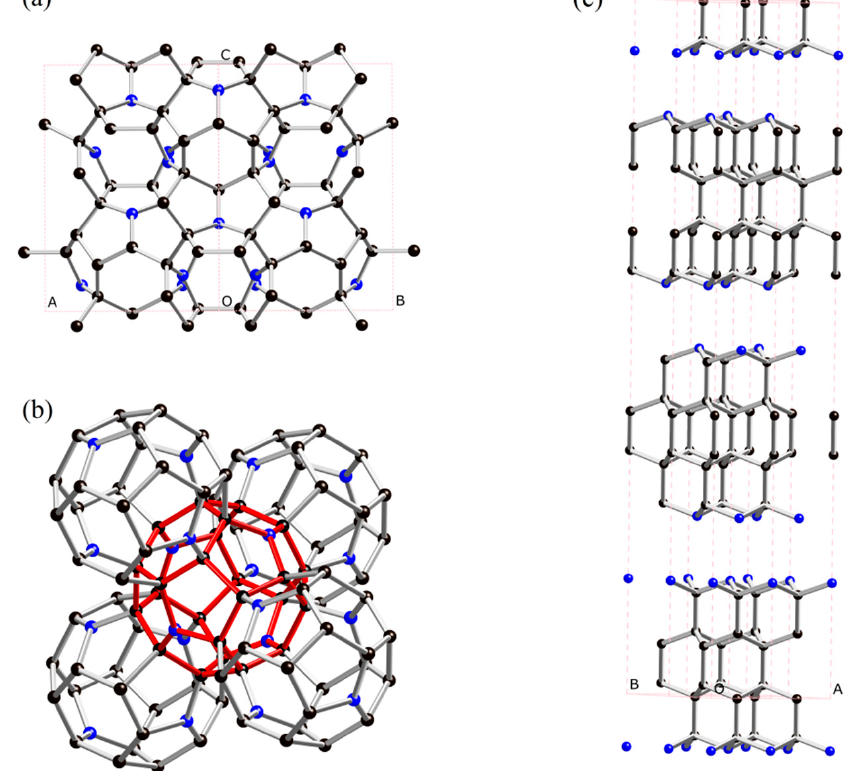
Figure 1. Crystal structure of c -C 3 N in [100] view ( a ); cages in c -C 3 N ( b ); and 2 × 1 × 1 supercell of R 3 m -C 3 N ( c ). The blue and black balls represent the N and C atoms, respectively. To clearly show the relative position relation of cages, the central cage is shown in red.